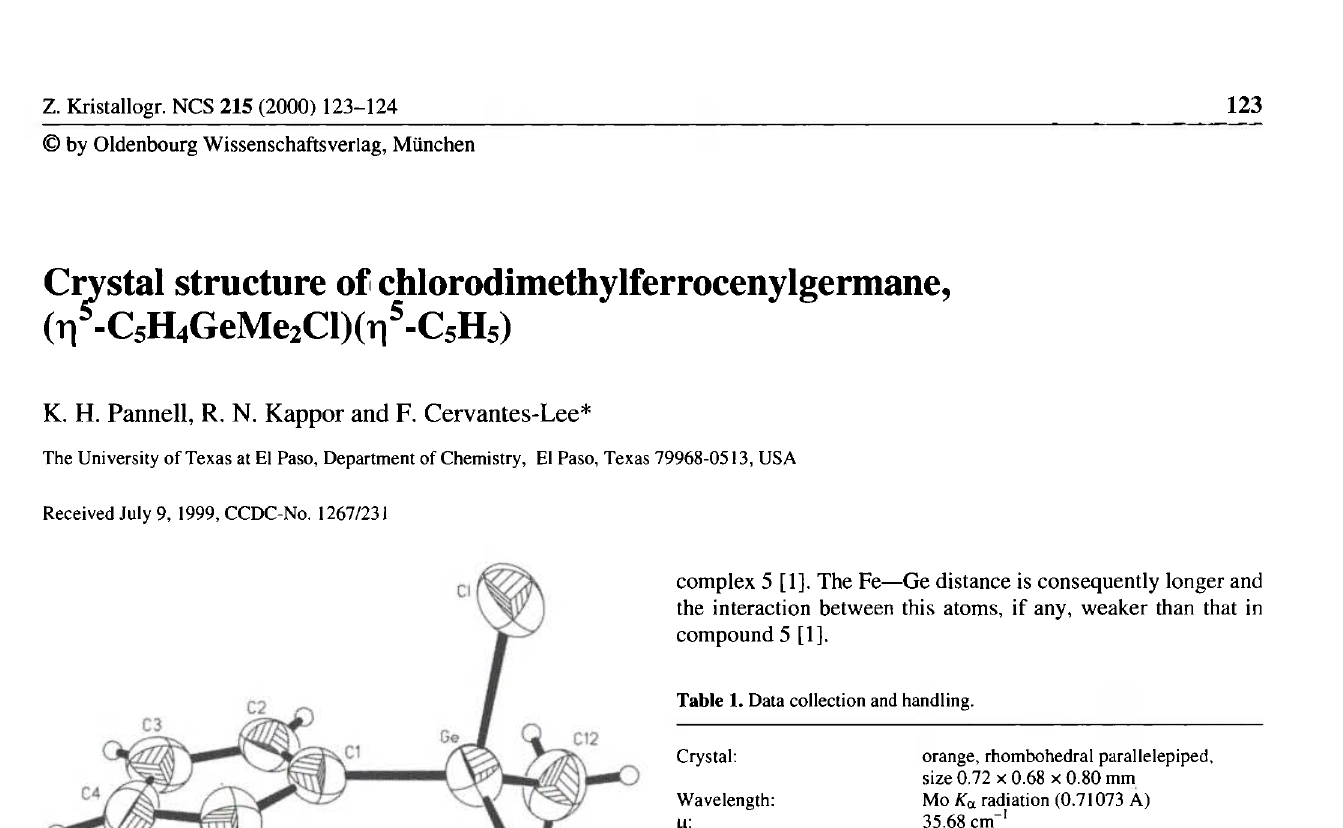
Table 2. Atomic coordinates and displacement parameters (in Ä 2